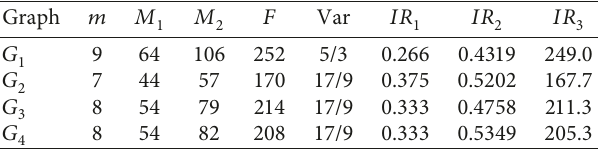
Table 1: Computed topological indices of the four graphs shown in Figure 1.